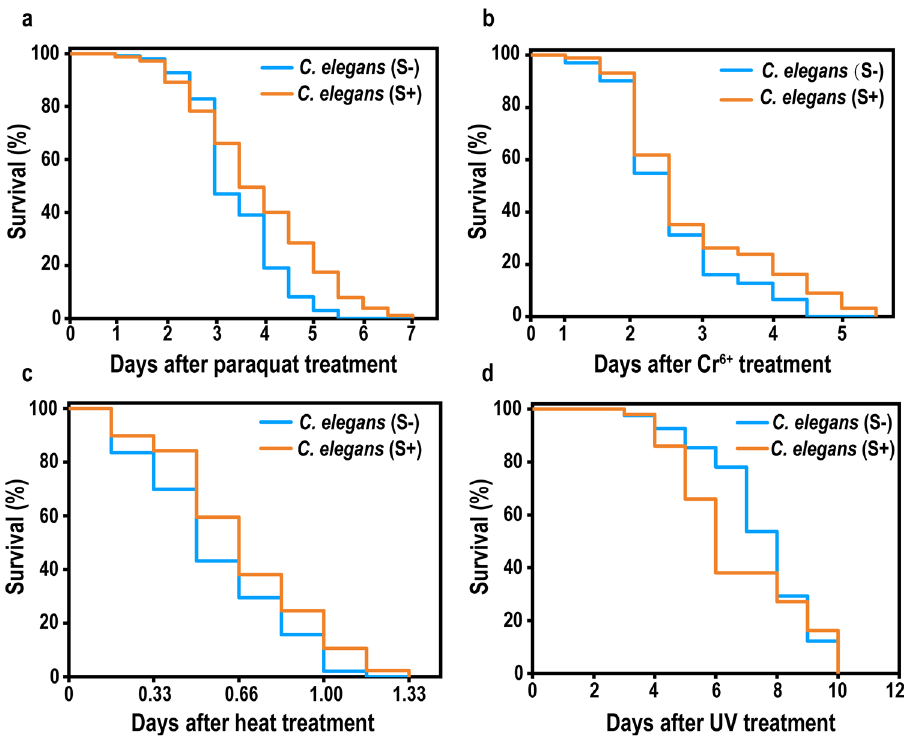
Fig. 3 Susceptibility of the two groups of nematodes to acute stresses. Survival percentages after treatment with ( a ) paraquat ((30 mM n S − = 138, n S + = 146, p -value < 0.05), ( b ) Cr 6 + ((10 mM n S − = 111, n S + = 109, p -value < 0.05), ( c ) heat shock (35 °C for 6 h, n S- = 127, n S + = 136, p -value < 0.01), and ( d ) ultraviolet irradiation (n S- = 41, n S + = 38, p -value < 0.001). Animals were exposed to the stresses on day 3 after L4-to-adult molts, and p -values were calculated with the log-rank